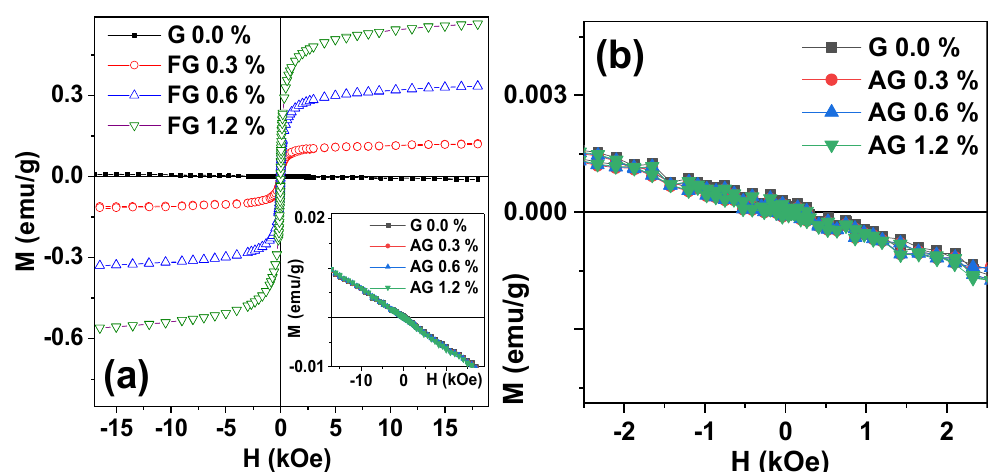
Figure 4. Magnetic hysteresis loops of gels and gel-based composites: MNP-based ( a ) and ANP-based ( b ) materials. G: blank gel; FG: Fe 2 O 3 -based ferrogels; AG: Al 2 O 3 -based gel composites.